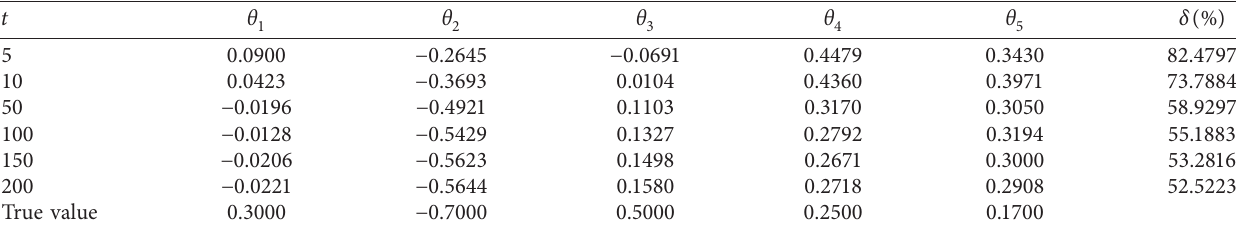
Table 2: The parameter estimates and the estimation errors (TI-SG).